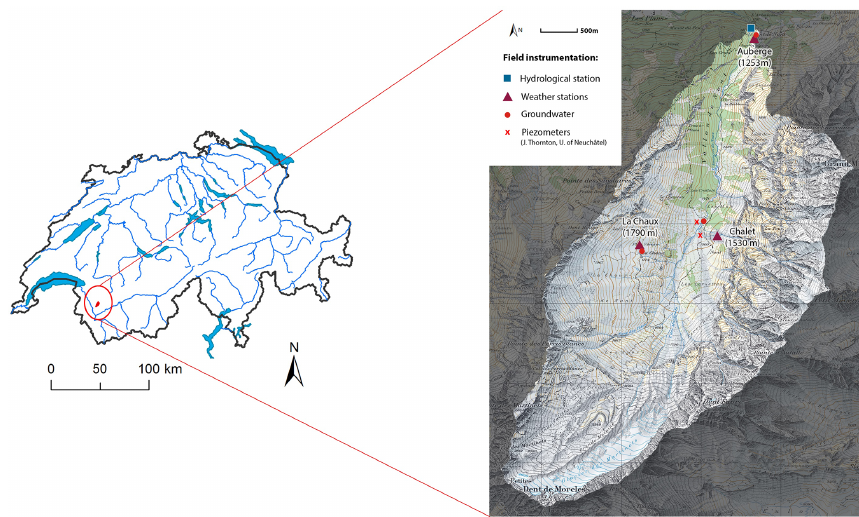
Figure 1. Map showing Vallon de Nant along with the locations of meteorologic and hydrologic observations as well as frequent sampling sites. Composite samples of precipitation were collected at the weather stations. Groundwater samples were collected at the groundwater monitoring points and the installed piezometers. The groundwater piezometers were installed by James Thornton from the University of Neuchâtel (Thornton et al., 2018).